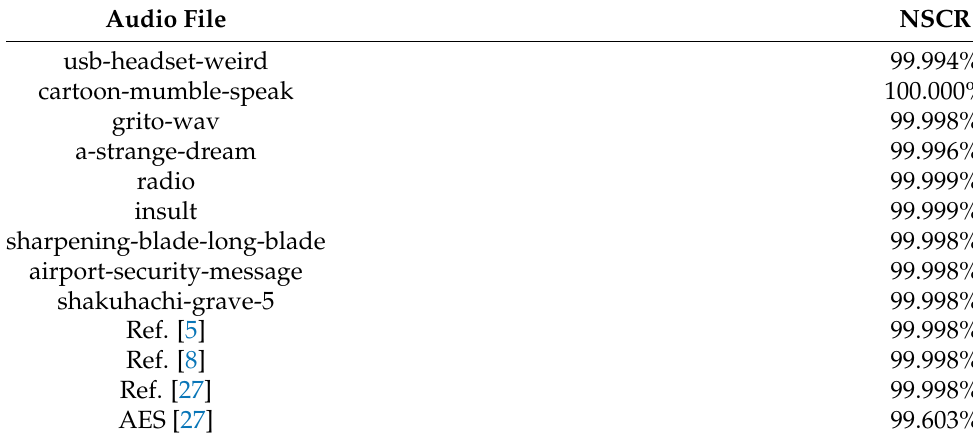
Table 2. Number of the sample change